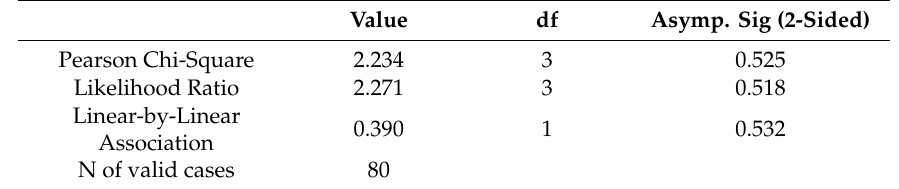
Table 7. Chi-square test: Quality management and its impact on prosperity and economic development. Value df Asymp. Sig (2-Sided) Pearson Chi-Square 2.234 3 0.525 Likelihood Ratio 2.271 3 0.518 Linear-by-Linear 0.390 1 0.532 Association N of valid cases